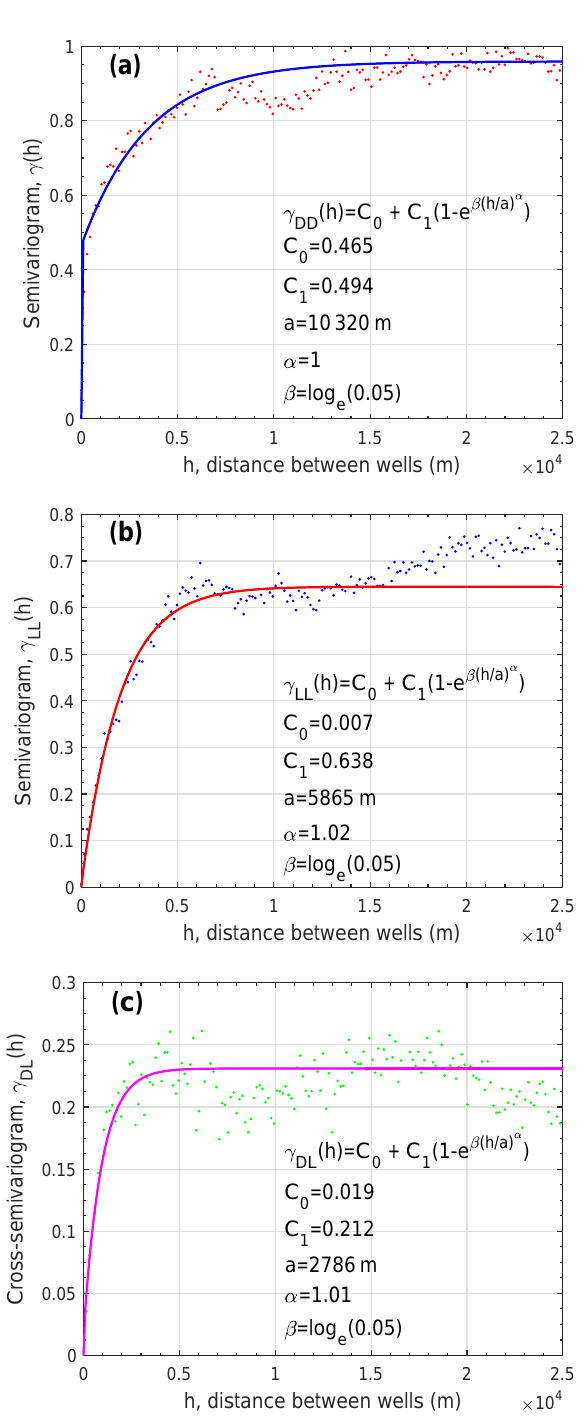
Figure 6. Semivariogram and cross-semivariogram functions for normal score data: semivariograms for sediment thickness Z D (a) ; and horizontal distance to the nearest outcrop Z L (b) . Cross- semivariongram for Z D and Z L (c) . Dots indicate the experimental data and solid lines are the model functions.